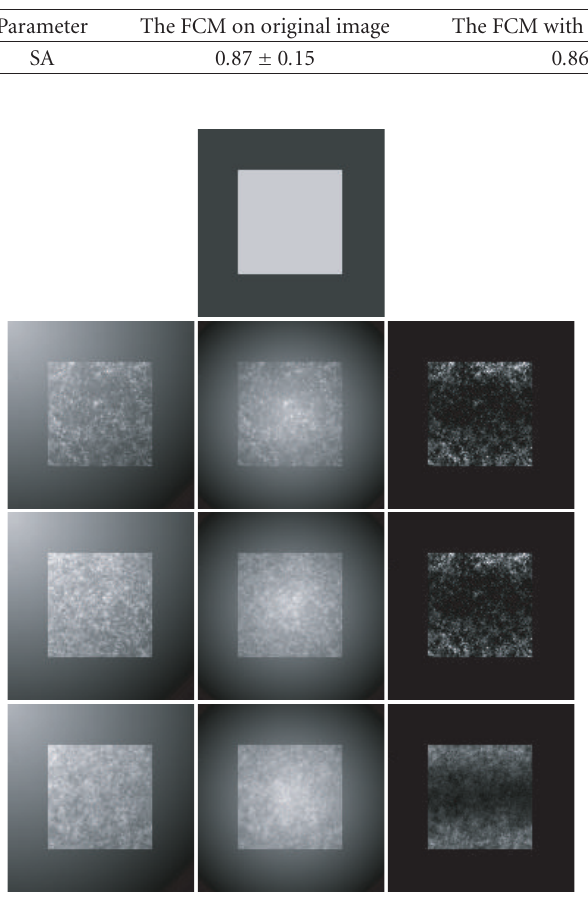
Figure 4: Synthetic images under di ff erent imaging conditions. First row: the ground truth image. From the second row to bottom: synthetic images with di ff erent photons density along the vertical direction and di ff erent types of intensity inhomogeneity along the horizontal